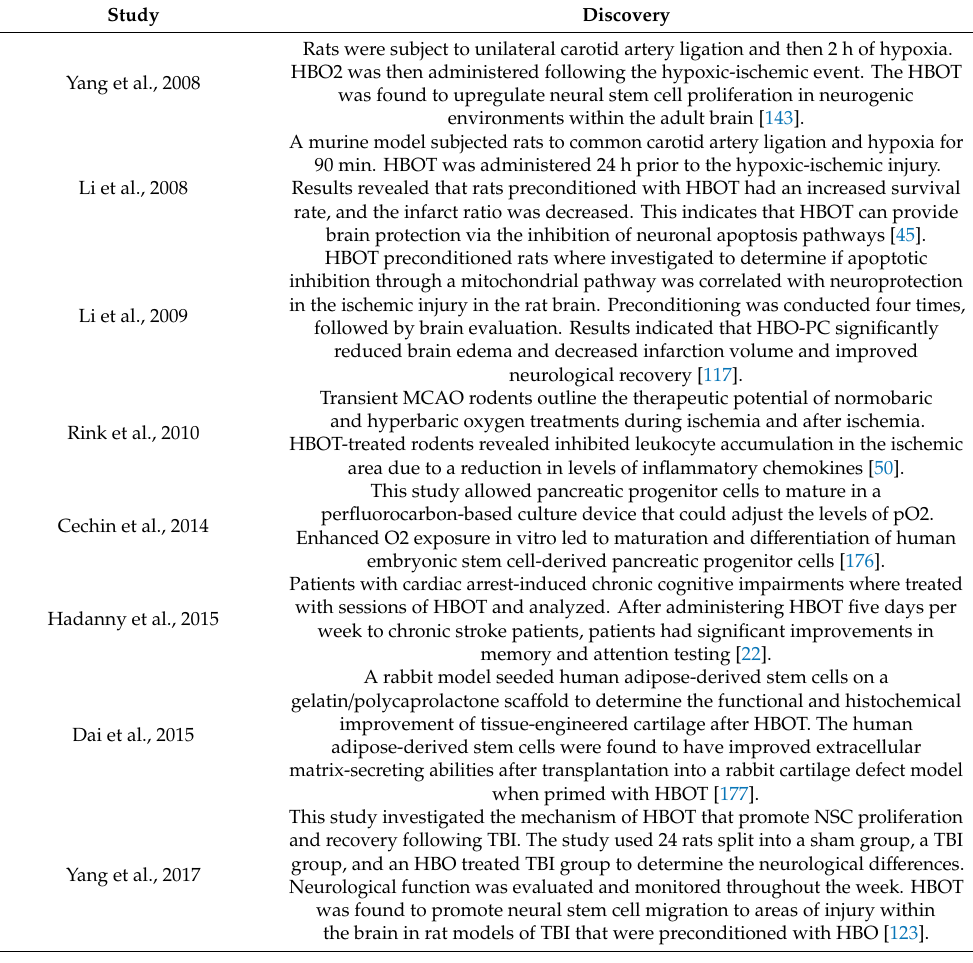
Table 2. Milestone Studies on the Use of HBOT for Stem